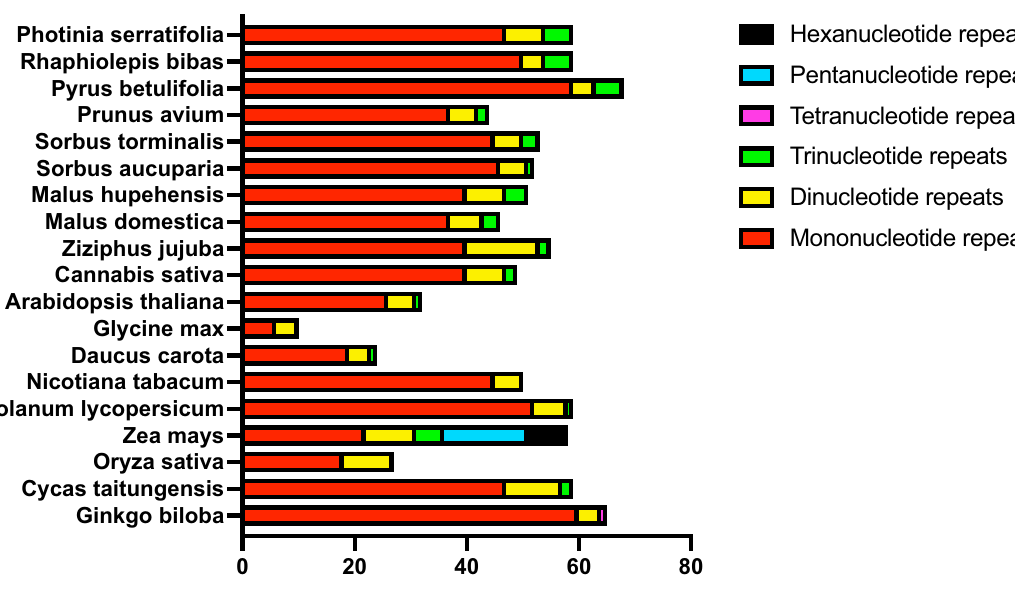
Figure 3. The SSRs composition in plant